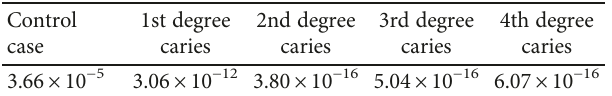
Table 2: Unitary strain.